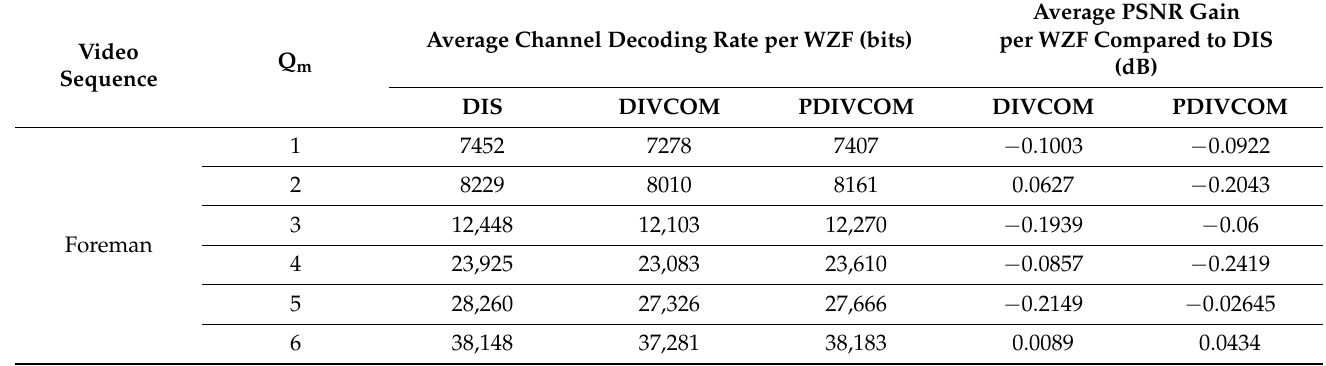
Table 7. Coding efficiency analysis of proposed novel online CNM for “Foreman” video